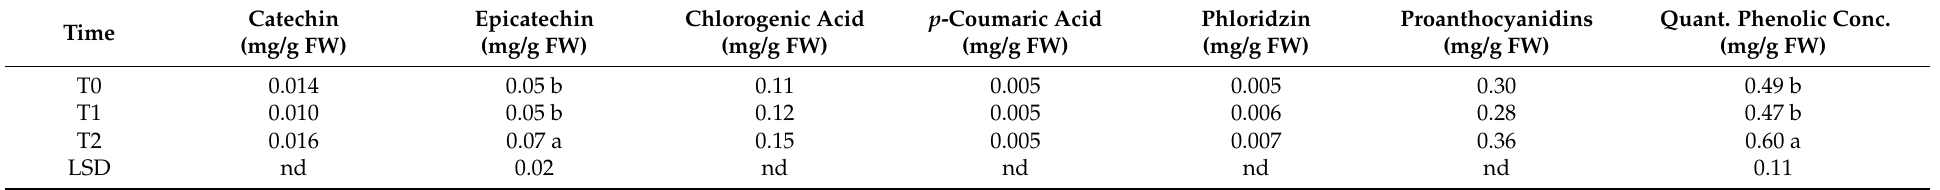
Table 1. Phenolic compound concentrations at each time point after cutting (averaged from all cultivars) and quantified phenolic concentration (QPC). Time